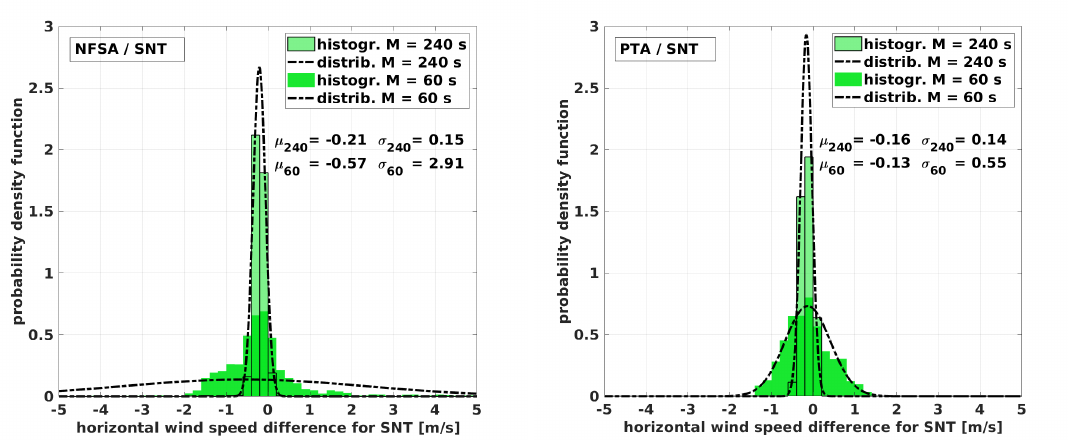
Figure 15. Normalized distribution and probability density function with the fitted normal distribution for the flight over complex terrain near Schnittlingen ( SNT ). The plots show the deviation between the MHPA and the NFSA ( left ) and the MHPA and the PTA ( right ) for M = 240 s and for M = 60